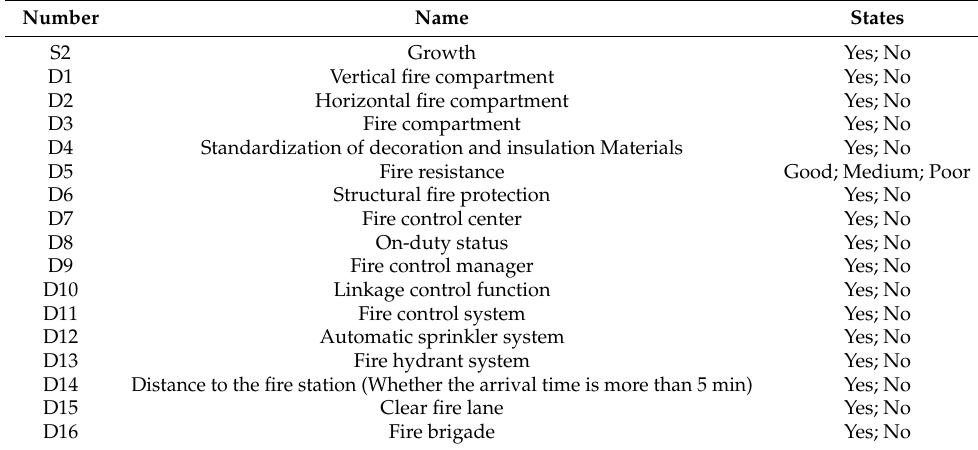
Table A6. The name and states of the nodes related to development in Bayesian